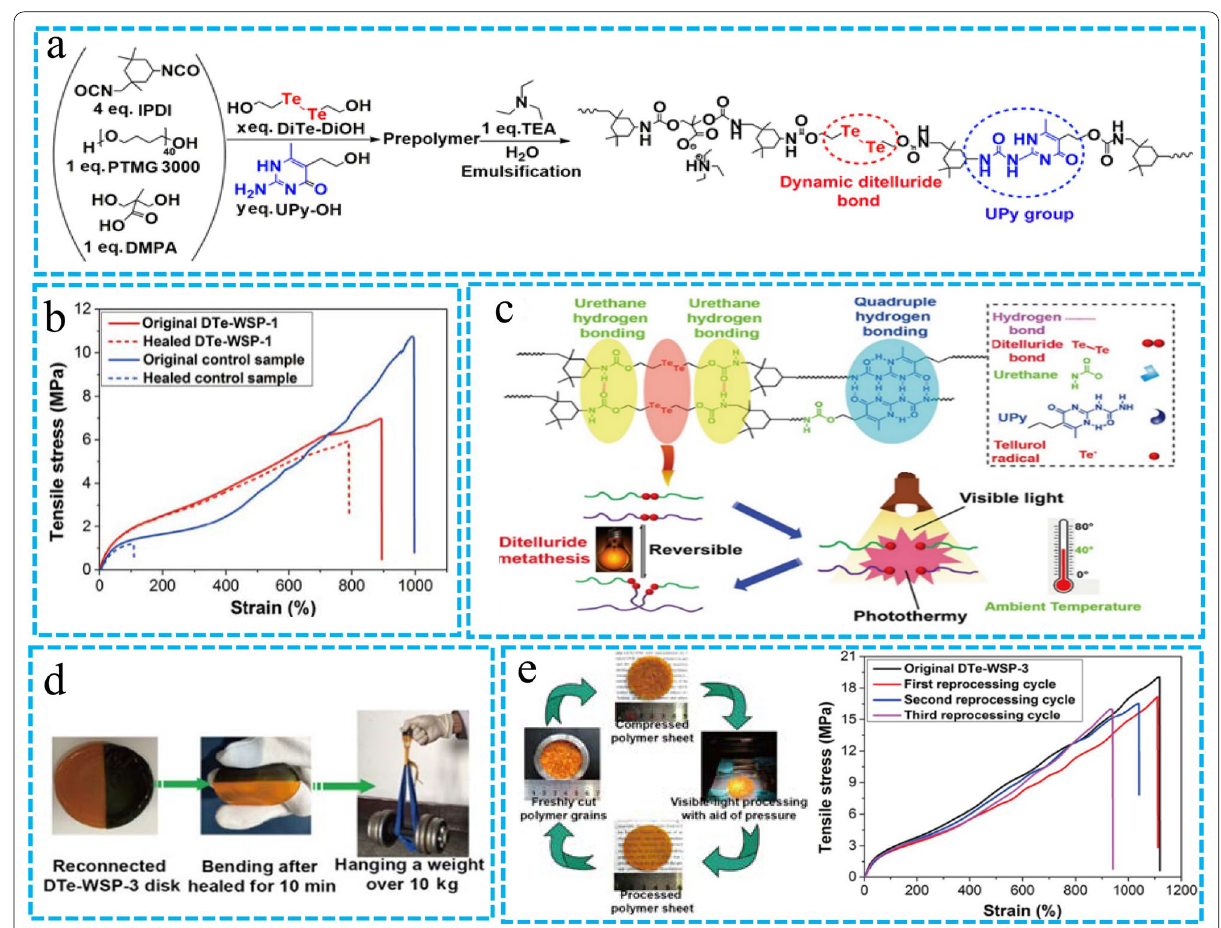
Fig. 4 a Synthetic route and chemical structure of the DSe-WSP. b Tensile behaviors of the healed and the virgin DTe-WSP-1 samples. c Schematic diagram of visible light-induced self-healing mechanisms of DTe-WSPs. d The round DSe-WSP film sample healed for 10 min lifted up a 10 kg dumbbell. e Recycling process of the DTe-WSP samples under visible light and stress strain curves of DTe-WSP for three reprocessing cycles. − Reprinted with permission form Reference[28]. Copyright 2020, American Chemical